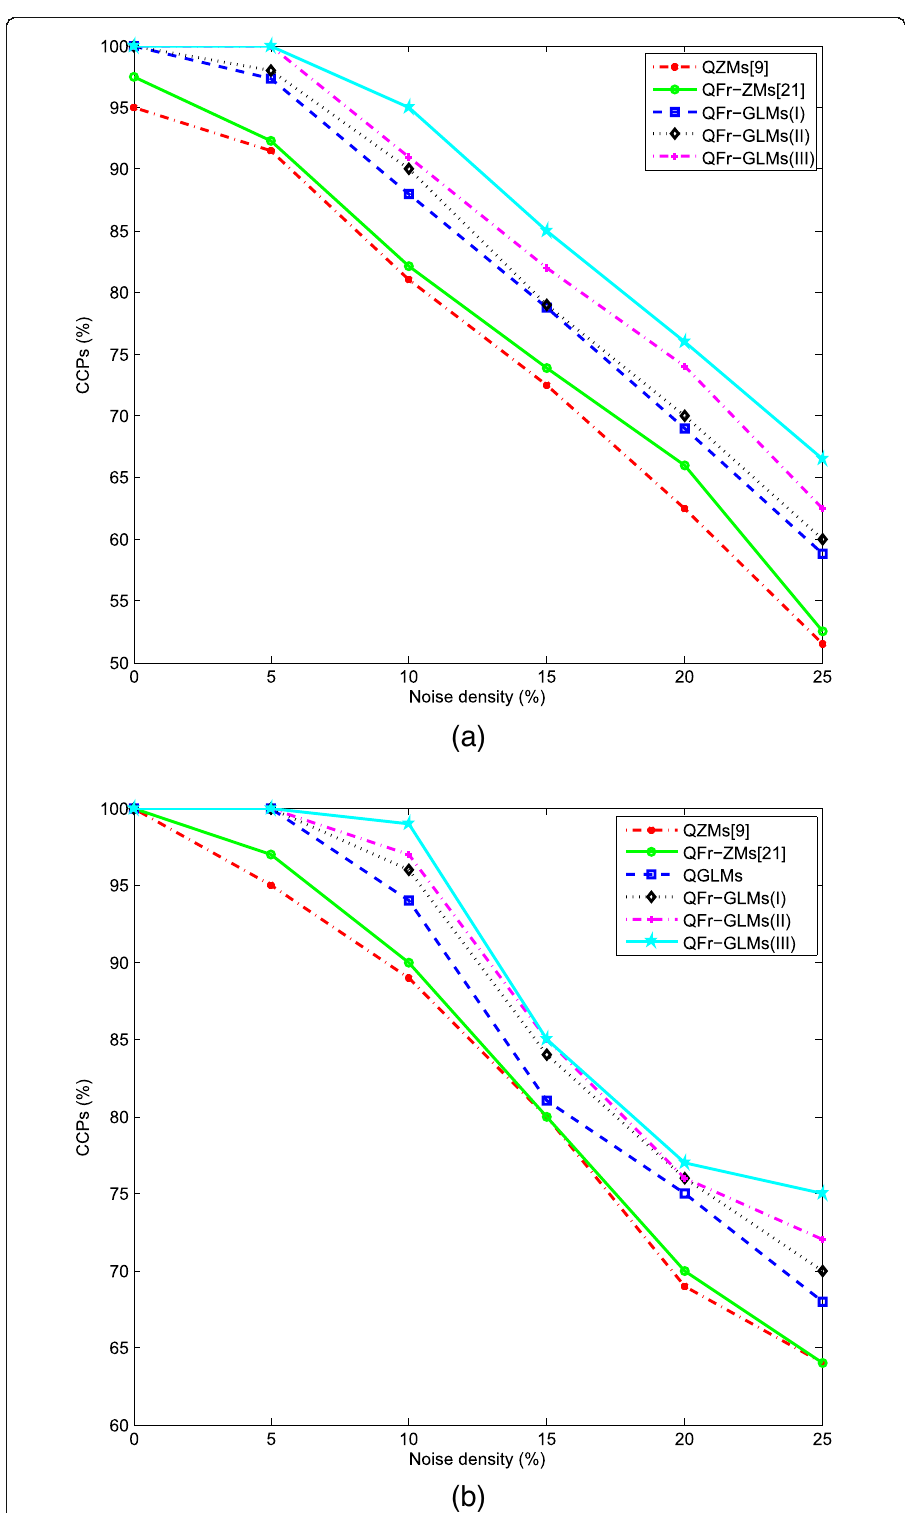
Fig. 12 Classification results of the COIL-100 color image dataset: a low-order moment ( k = 12) and b high- order moment ( k =